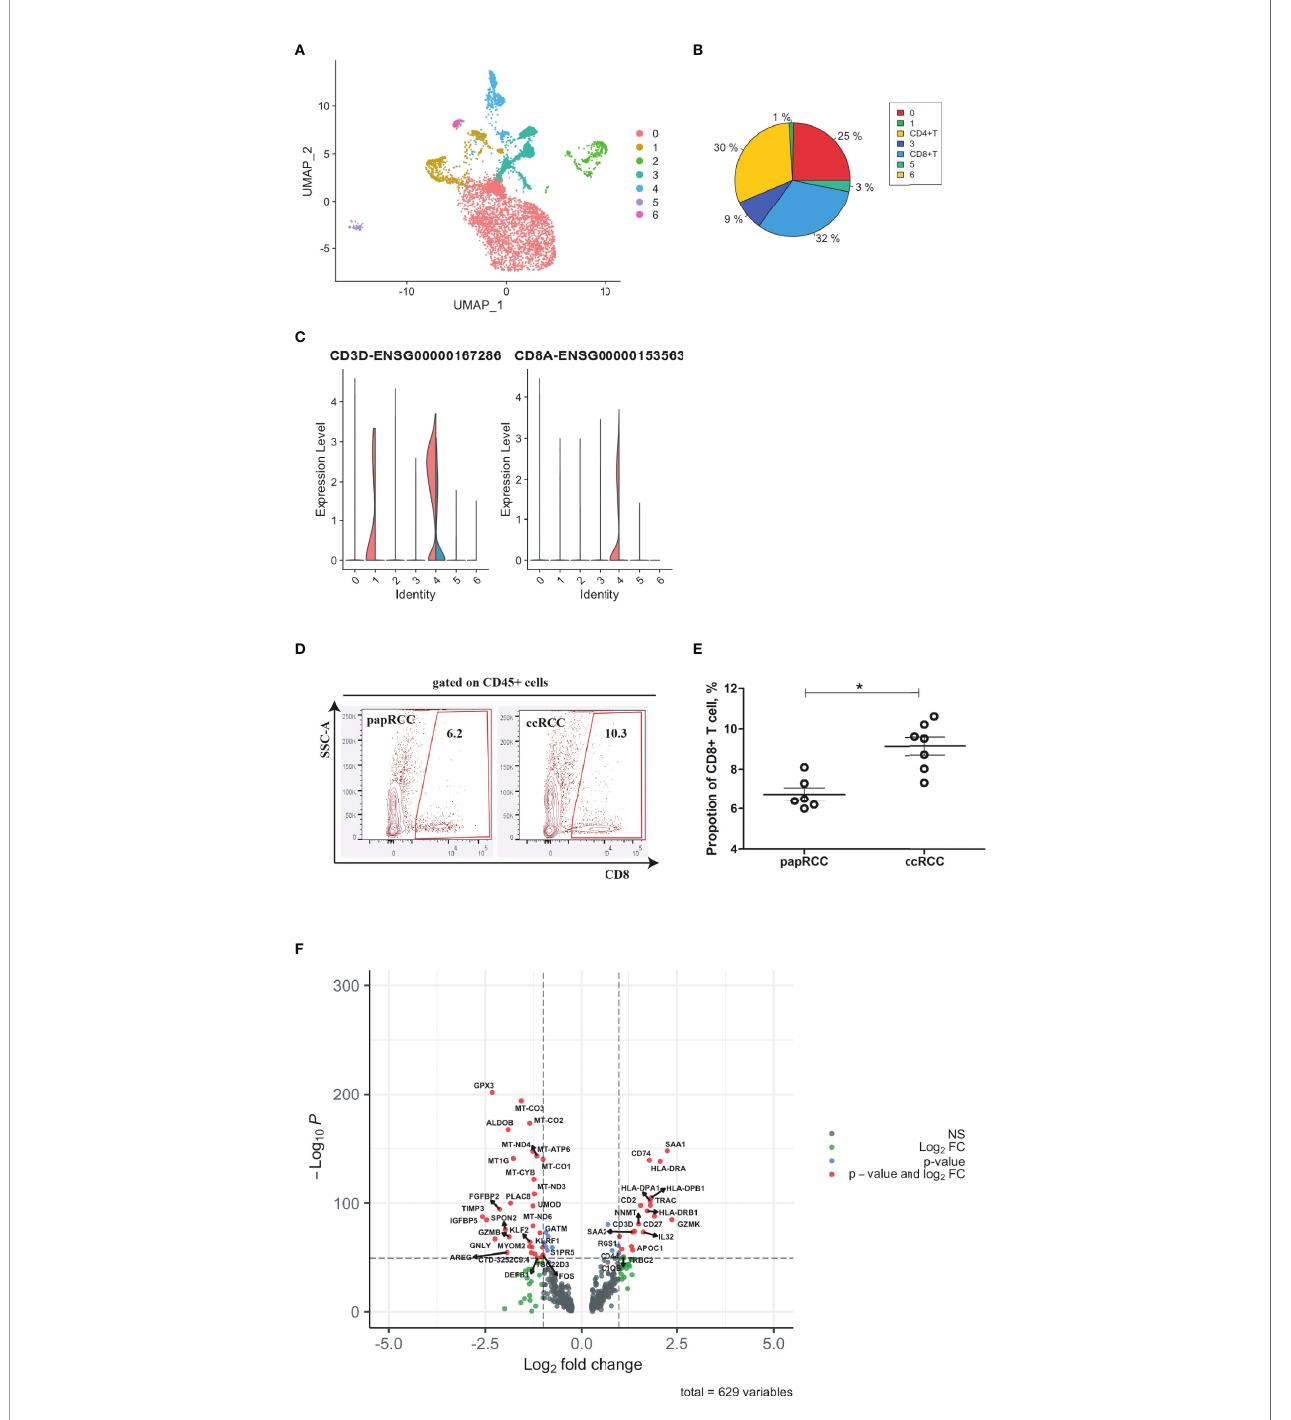
FIGURE 2 | Identi fi cation of CD8+ T cell-related genes in clear cell renal cell carcinoma (ccRCC). Single cell RNA (scRNA) data were presented with UMAP clustering using R package Seurat (https://satijalab.org/seurat/v3.1/integration.html). (A) UMAP plot showing seven cell clusters in integrated ccRCC and papillary renal cell carcinoma (papRCC) biopsies. (B) Pie plot indicating cell proportions in integrated biopsies. (C) Combined violin plots showing the comparison of gene expression levels of T cells and CD8+ T cells between ccRCC (red) and papRCC (cyan). (D) Flow cytometry analysis of CD8+ T cells in RCC patients. Contour plots showed the frequency of CD8+ T cells in RCC biopsies isolated from patients. (E) Dot plot showed statistical analysis of CD8+ T cells in RCC biopsies isolated from patients. Each dot represented one readout. Nonparametric analysis was used. *: p<0.05. (F) Volcano plot showing the distribution of 629 differentially expressed genes (DEGs) expressed by CD8+ T cells (ccRCC vs.